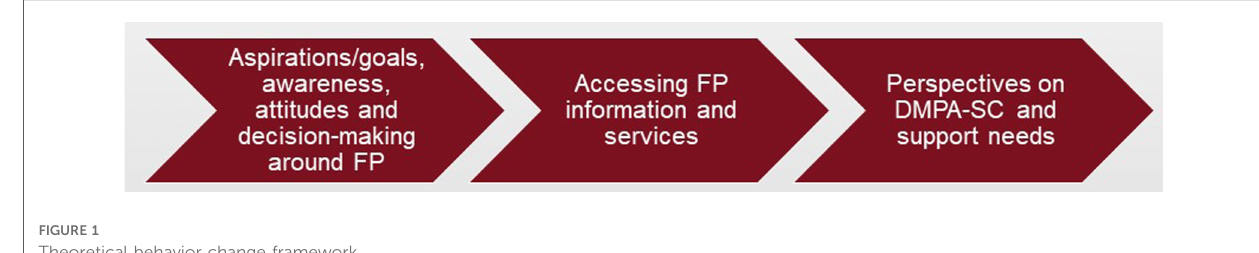
FIGURE 1 Theoretical behavior change framework.